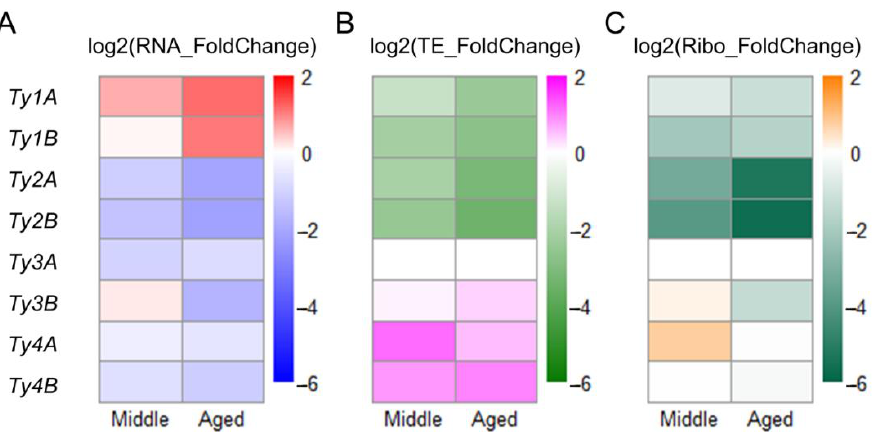
Figure 5. Changes in expression of TyA and TyB genes in Middle and Aged cells. Young cells were used as a control. ( A) Changes in transposon RNA. Red and blue indicate upregulation and downregulation, respectively. ( B ) Changes in transposon translational efficiency (TE). Magenta and green indicate upregulation and downregulation, respectively. ( C ) Changes in transposon Ribo-Seq footprints. Orange and dark green indicate upregulation and downregulation, respectively. Ty5 genes were not detected.